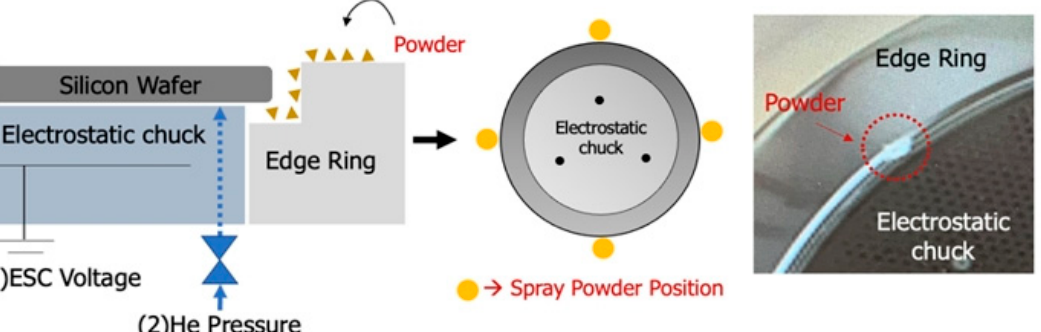
Figure 8. (1) ESC voltages (2500, 2000, 1700, and 1500 V) and (2) helium pressures for the ESC (30, 25, 20, and 15 Torr).